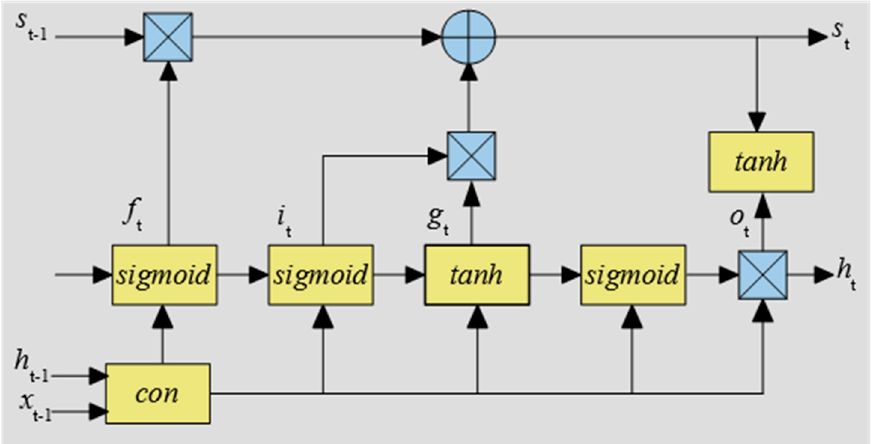
Figure 1. The structure of the long short-term memory (LSTM) unit.